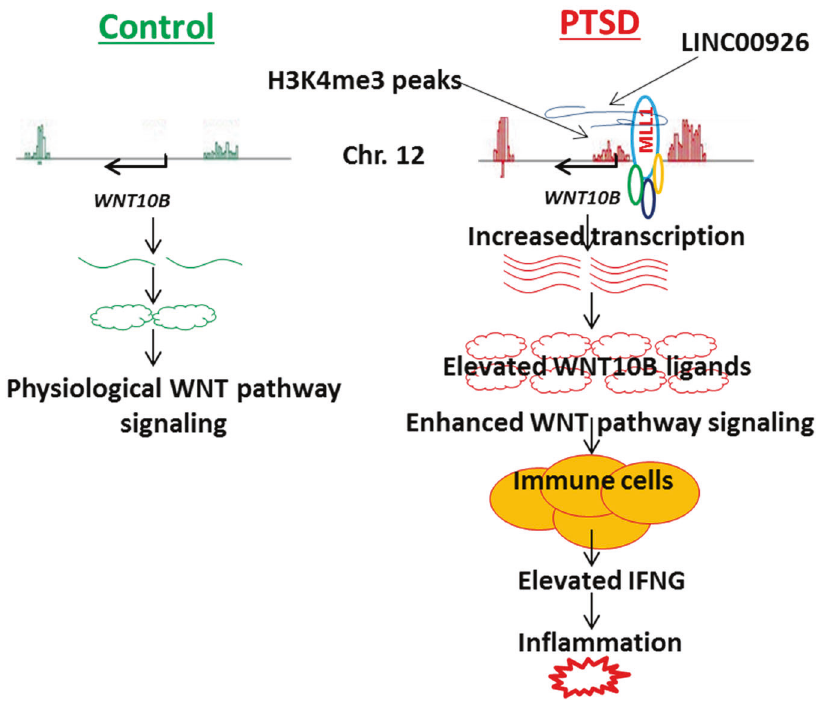
Fig. 6 Schematic explaining the role of LINC00926 in orchestrating the regulation of WNT10B in order to regulate IFNG expression. In order to introduce H3K4me3 methylation around WNT10B promotor, LINC00926 associates with MLL1 and brings it to the promotor of WNT10B. This presence of MLL1/LINC00926 complex around WNT10B promotor upstream of TSS, introduces H3K4me3 in this region in PTSD. This results in easy access of the transcription complex and thereby increased transcription of WNT10B leading to increased WNT signaling in PTSD. Consequently, the expression of in fl ammatory genes like IFNG and IL17A are elevated due to increased WNT signaling, leading to in fl ammatory state in PTSD patients. On the contrary, in controls, WNT10B expression is not altered and therefore it is present at physiologically favorable levels, and therefore, the expression of in fl ammatory genes is not